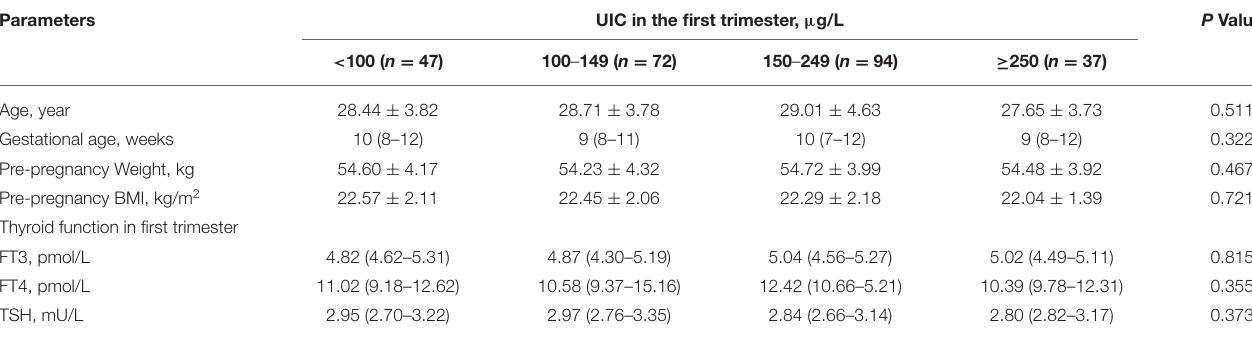
TABLE 4 | Baseline characteristics and thyroid function in the first trimester among follow-up visits of pregnant women by UIC group.